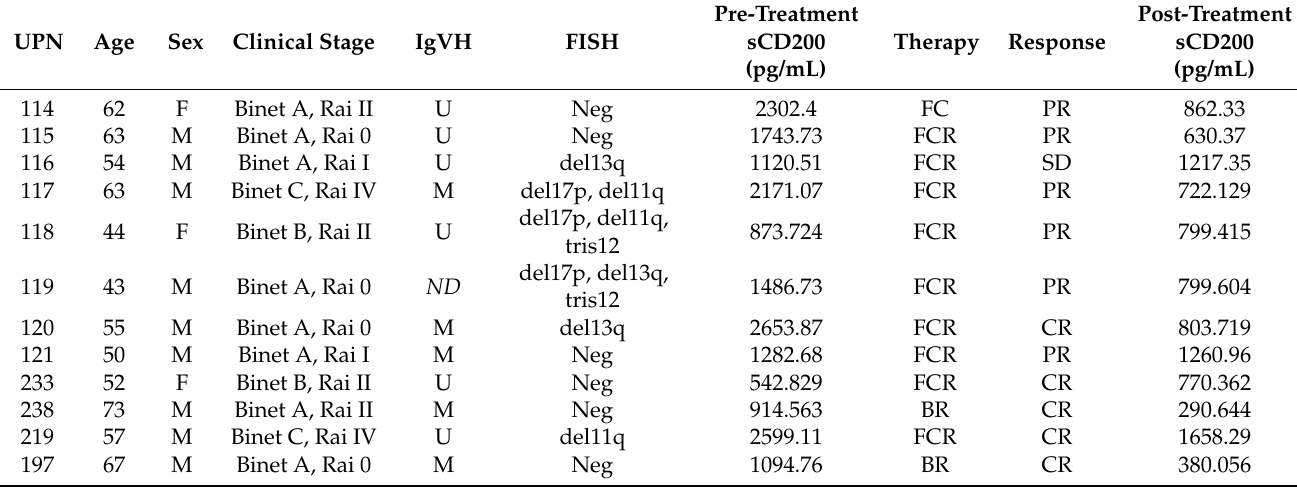
Table 2. Clinical and laboratory features of patients tested for sCD200 before and after therapy.